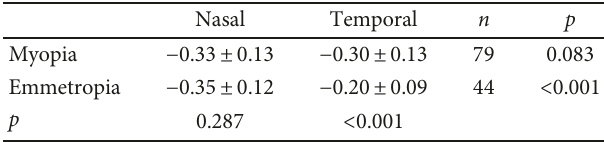
Table 1: The Q values of the anterior cornea of the adult group ( n = 123 ).